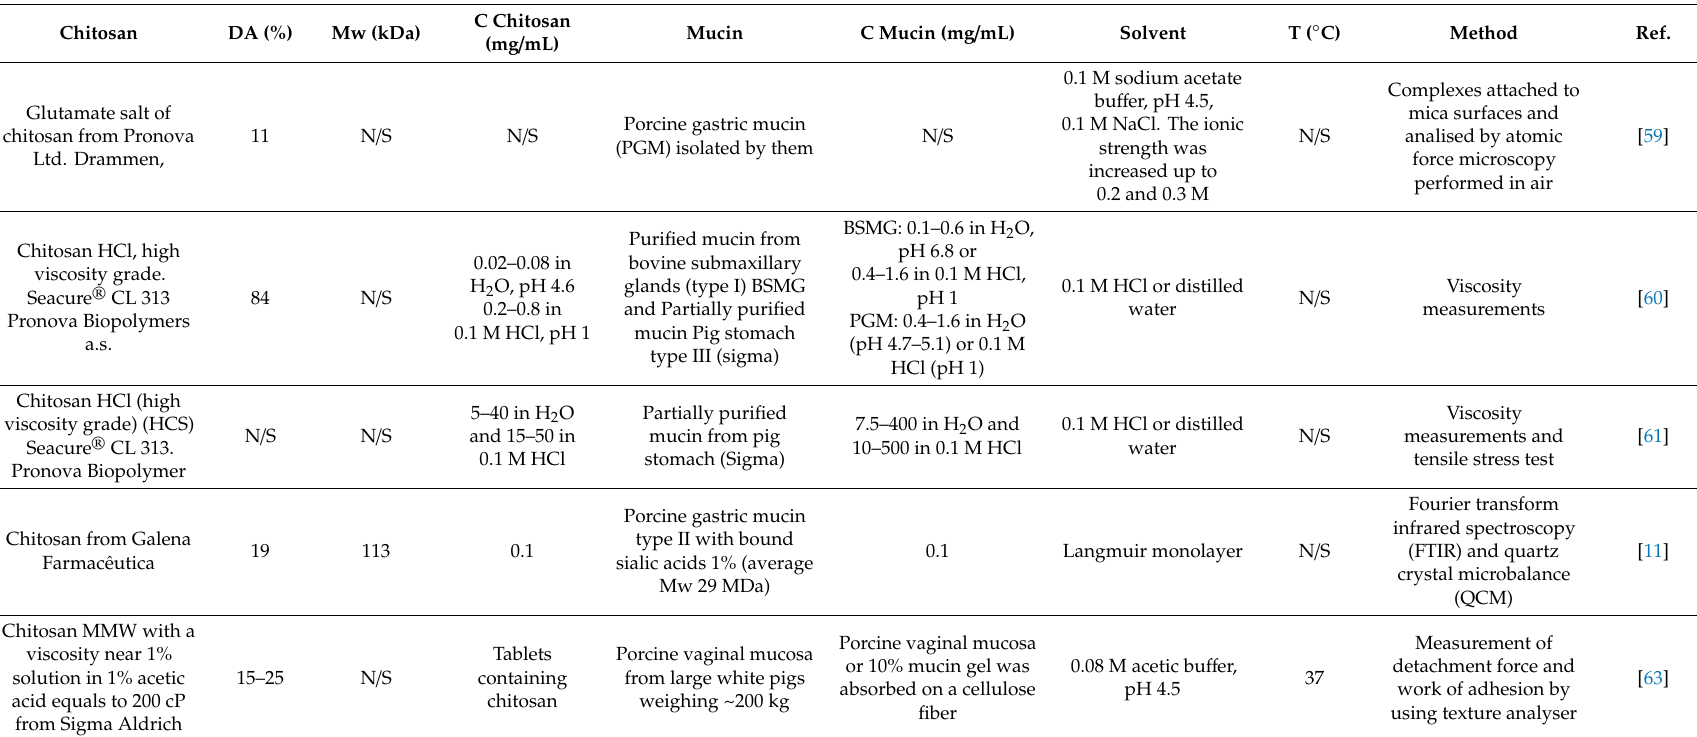
Table 2. Nanostructures composed of chitosan and